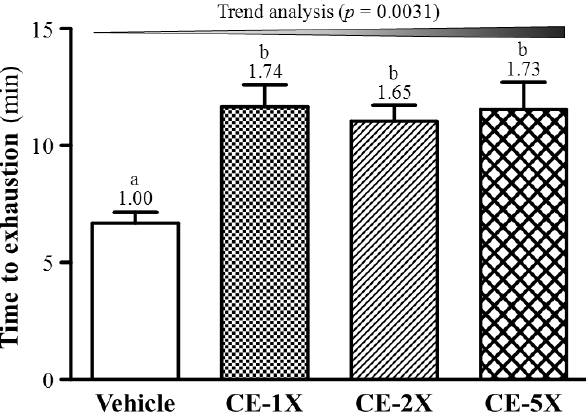
Figure 2. Effect of 4-week CE supplementation on exhaustive swimming time. Data are mean ± SEM for n = 10 mice per group. Bars with different letters (a, b) are significantly different at p < 0.05.